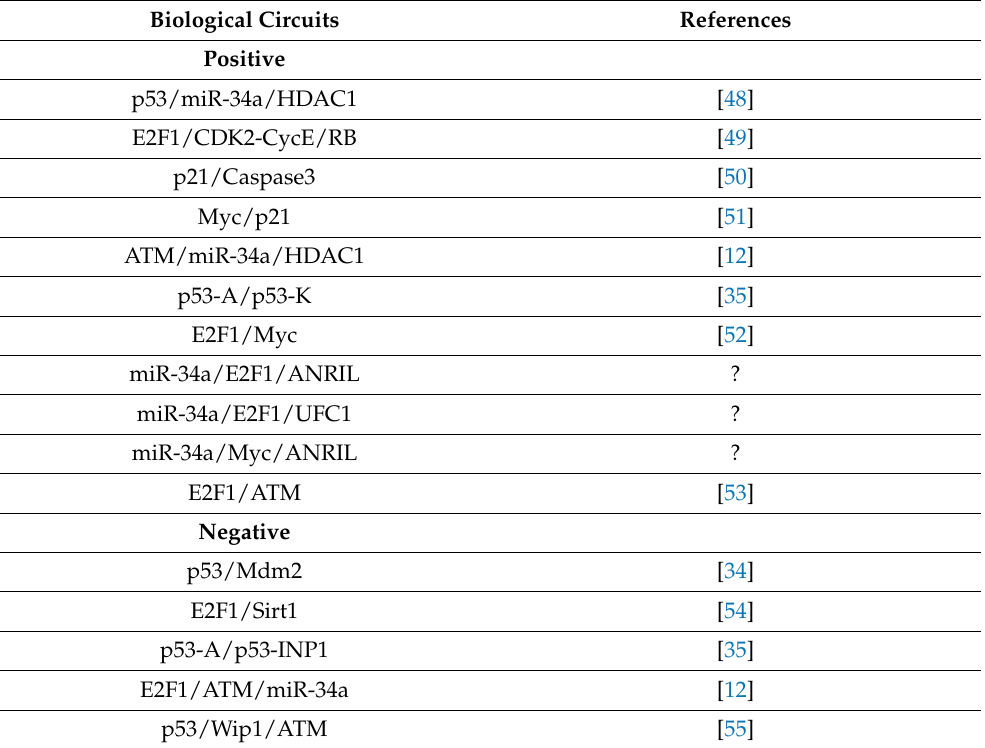
Table 2. Functional circuits of the model and experimental observations. Cases not studied experi- mentally are indicated by question marks